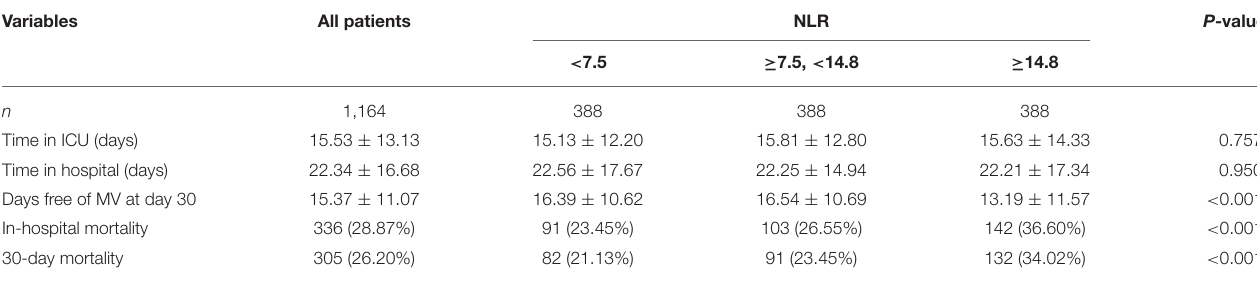
TABLE 2 | Outcomes of the patients with ARDS across tertile of the baseline NLR. Variables All